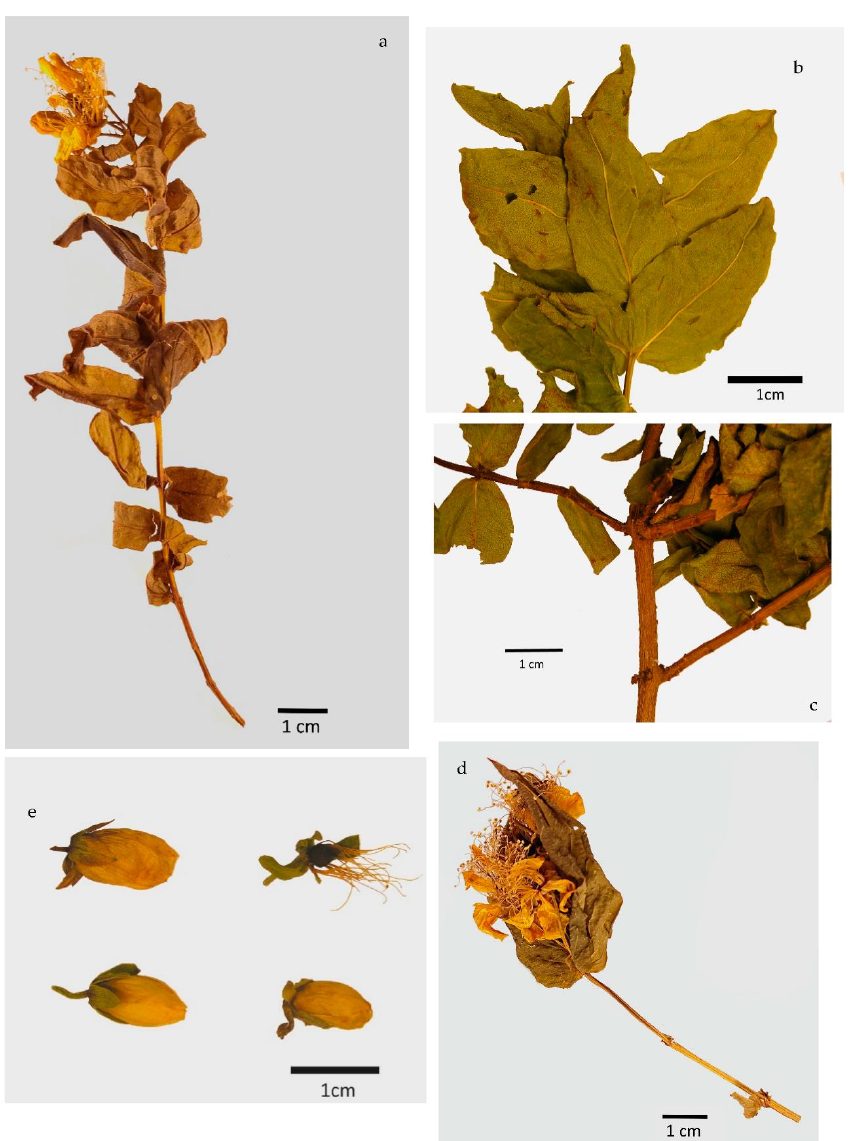
Figure 1. Macroscopic analysis photographs of the aerial parts of H. foliosum . 1 cm = 10 mm. ( a ) General view of the brown branched and bare stem and opposite and lanceolate leaves, with a whole margin and acute apex; ( b ) subsessile leaf details showing ovate-oblong form and stipules. The midrib originates at 45 – 60° angles from the secondary veins; ( c ) crenated stem surface with light brown color, dark pits, and longitudinal striation; ( d ) flowering aerial part; ( e ) different flowers showing yellow stamens surrounding three dark red carpels with lighter colored stigmas.